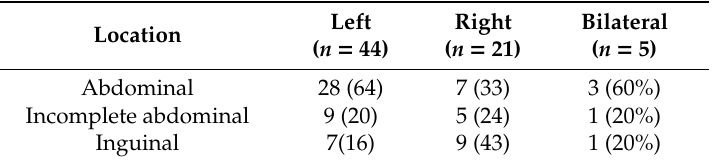
Table 1. Values are reported as number